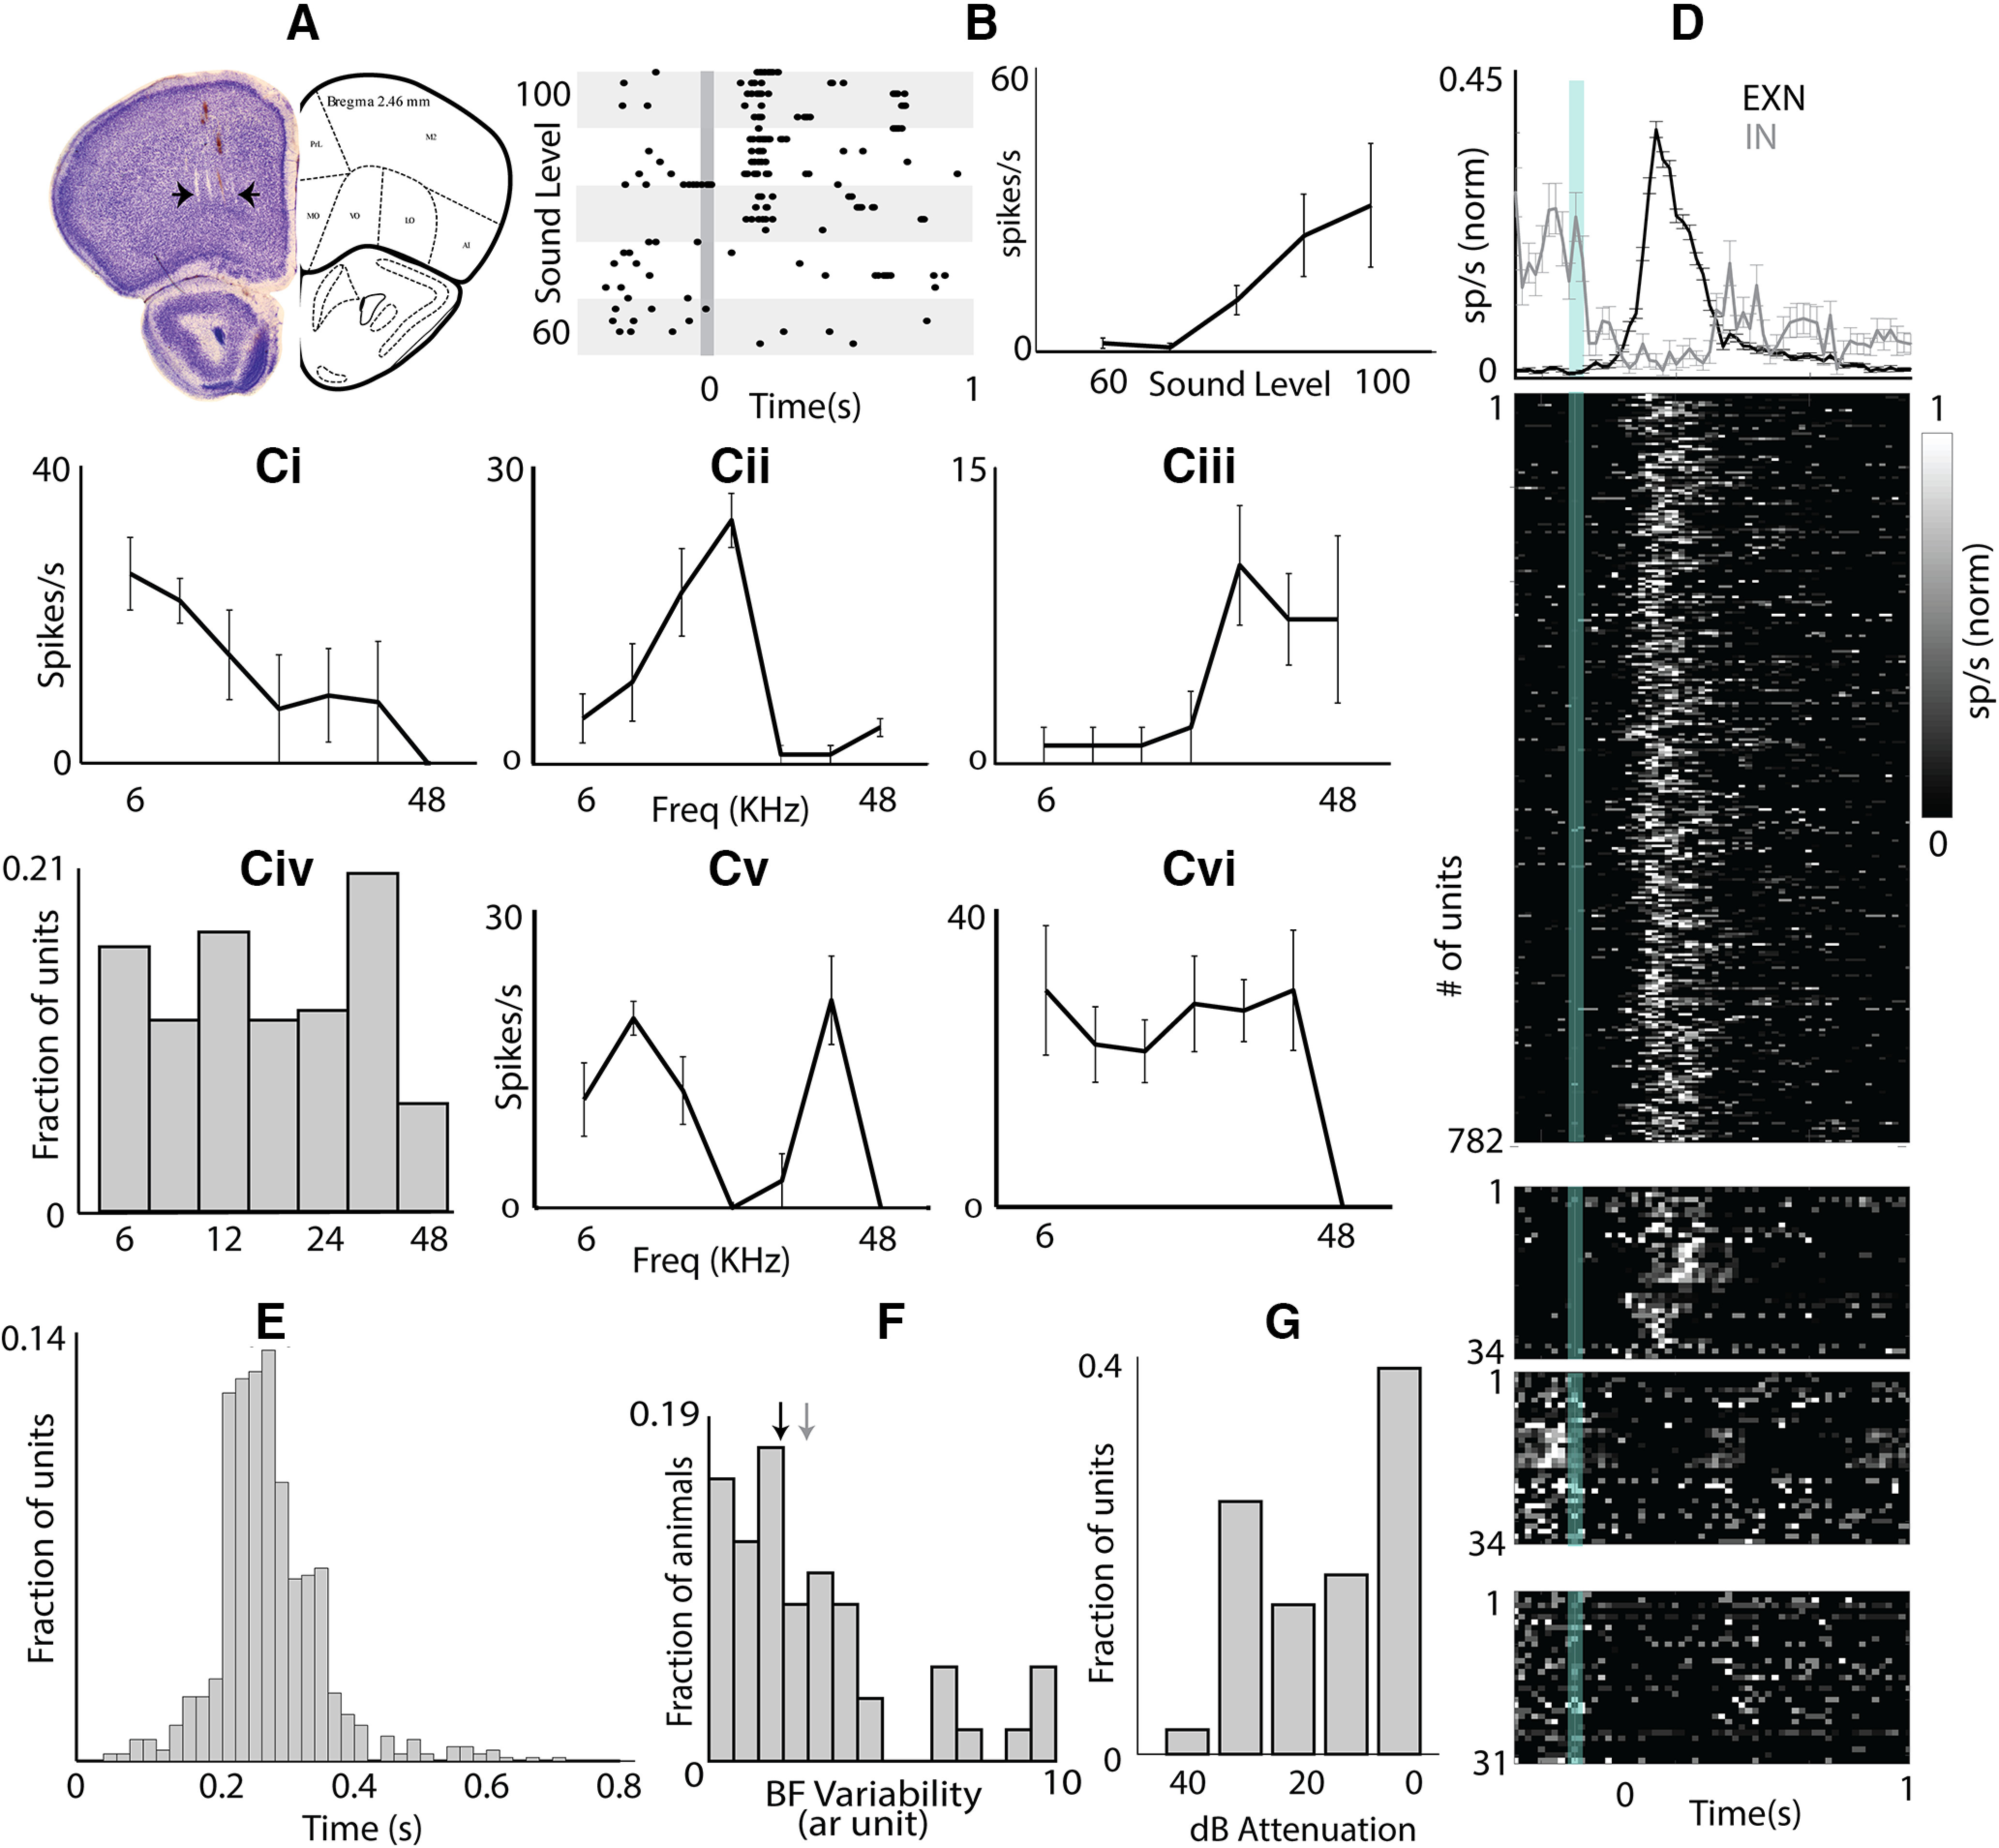
OFC responds to auditory stimulation. A, Nissl stain of OFC section showing electrode tracks. Black arrows mark the medio-lateral extent of the electrode array. B, An example unit showing responses to increasing intensities of broadband noise in raster plot (left) and rate-level curve (right). Ci–Ciii, Tuning curves of three example units tuned to low (Ci), mid (Cii), and high (Ciii) frequencies. Civ, Distribution of units tuned to different frequencies. Cv, An example unit with bimodal tuning curve. Cvi, An example unit with broad tuning curve. D, top, Mean normalized PSTH ± SEM of all units showing excitation (black) and inhibition (gray) on auditory stimulation. Bottom, Individual unit’s PSTH (upper panel: units showing excitation, middle two panels: units showing excitation to some frequency and inhibition to some other frequency, lower panel: units showing inhibition). E, Distribution of peak response latency to the BF. F, Spatial BF variability. Black arrow marks the median of the distribution and gray arrow marks the median of the distribution of completely random BF organization. G, Distribution of broad band noise thresholds; 0-dB attenuation corresponds to ∼90-dB SPL for a tone at 17 kHz.